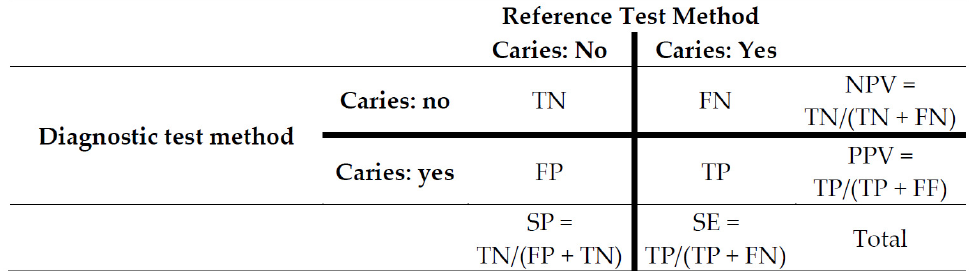
Figure 1. 2 × 2 contingency table for determining the validity of a distinct diagnostic test method in relation to a rigorous, mostly histology-based reference standard. The bold printed lines indicate the threshold value. True negative (TN)—The index test is negative, and the reference test is negative. True positive (TP)—The index test is positive, and the reference test is positive. False negative (FN)—The index test is negative, and the reference test is positive. False positive (FP)—The index test is positive, and the reference test is